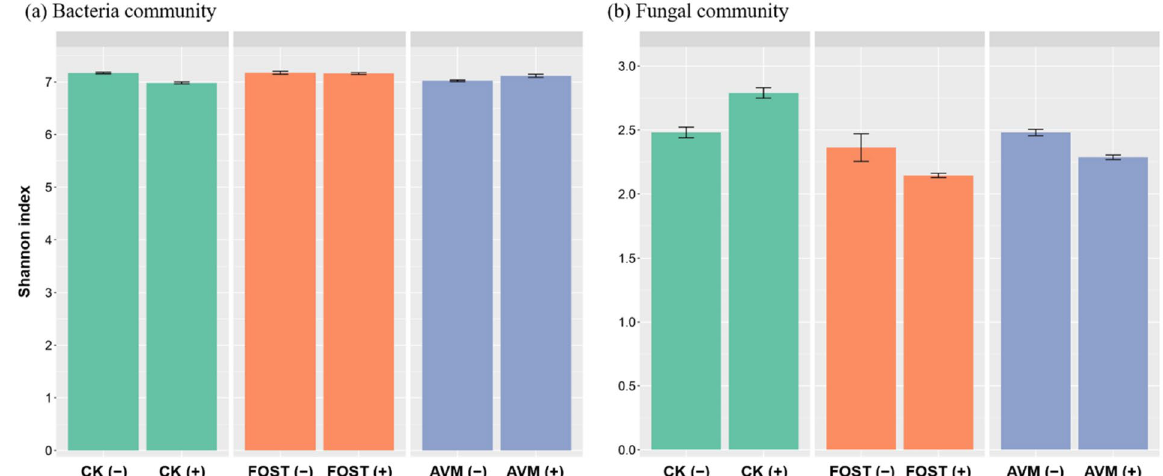
Figure 3. The effects of Burkholderia vietnamiensis B418 inoculation on microbial alpha diversity in the rhizosphere of greenhouse-grown watermelon. Columns show the Shannon index for ( a ) bacterial communities and ( b ) fungal communities within and among different treatments. CK: control; FOST: fosthiazate; AVM: avermectin. (+ /−) stands for with and without B418